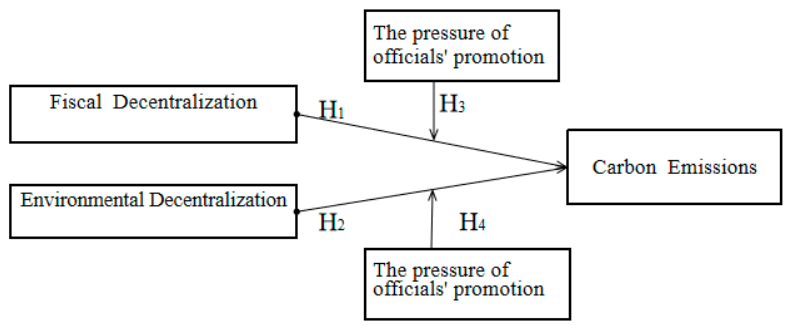
Figure 2. The theoretical model of this